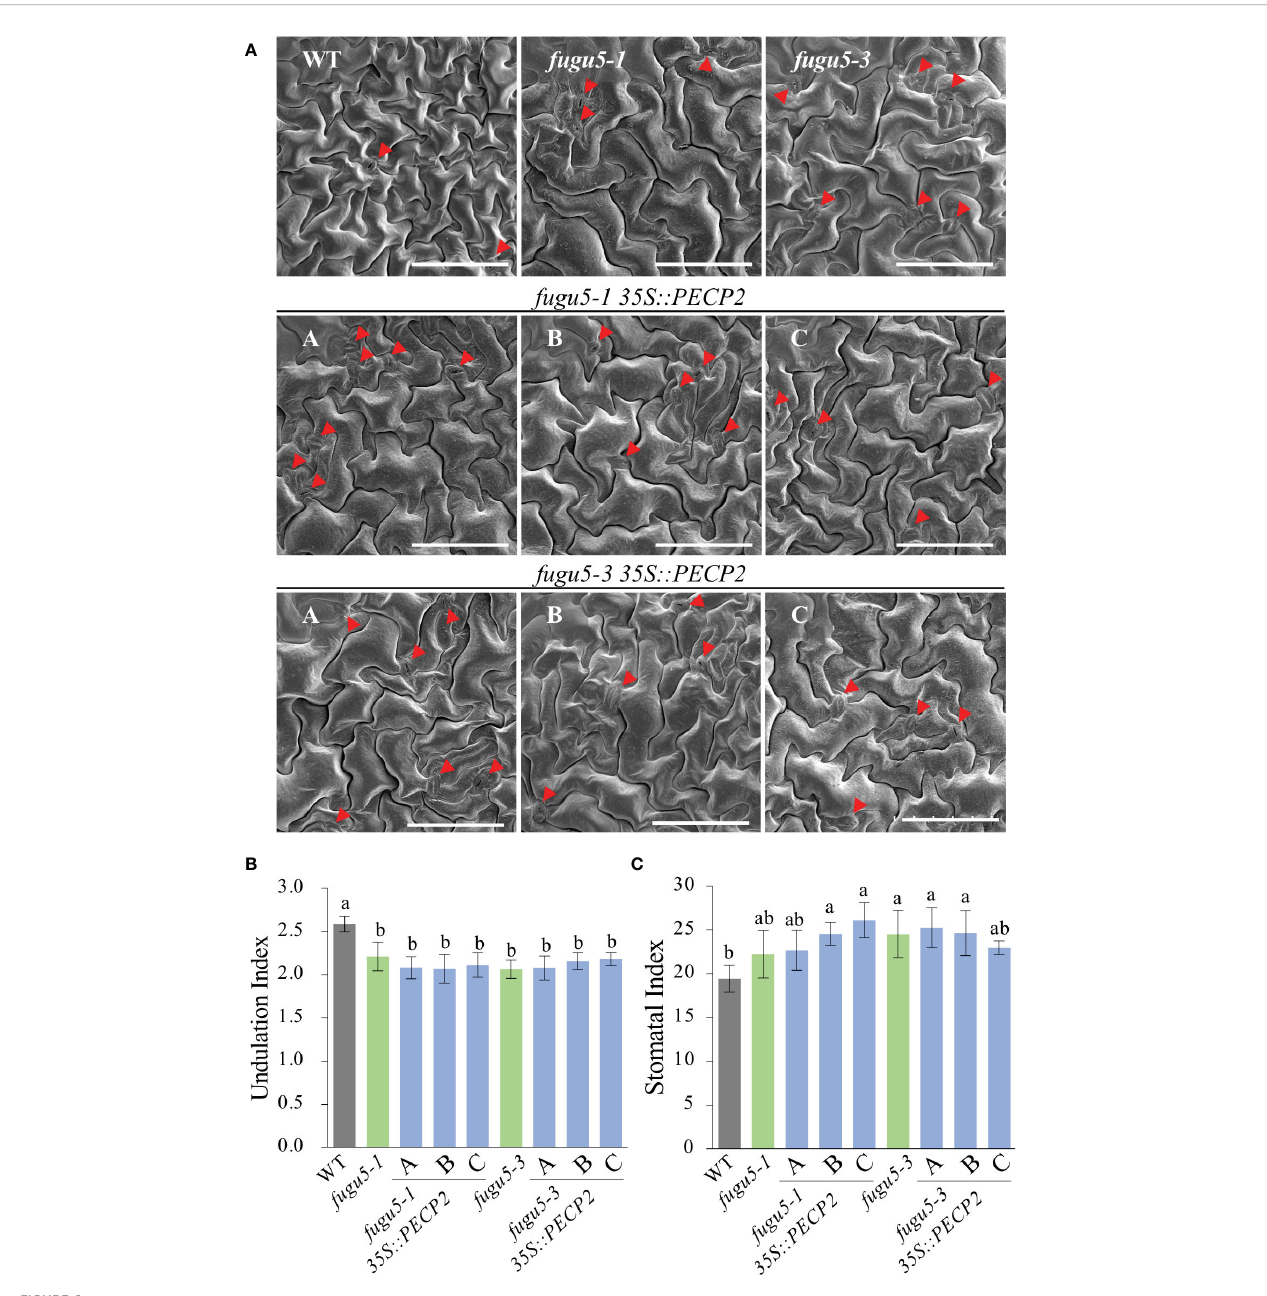
FIGURE 6 Quanti fi cation of pavement cell complexity and stomata distribution on the cotyledon adaxial side in PECP2 overexpressing lines in the fugu5 background. (A) Representative SEM images of pavement cells (PCs) from the cotyledon adaxial side of the WT, fugu5-1 , fugu5-3 , fugu5-1 35S::PECP2 , and fugu5-3 35S::PECP2 lines at 25 DAS. Red arrowheads indicate stomata. Scale bar = 150 µm. (B) Undulation index (UI) of PCs. Data are means ± SD ( n = 5 cotyledons). (C) Stomatal index (SI) determined as the number of stomata per 100 PCs. Data are means ± SD ( n = 5 cotyledons). Each character represents a signi fi cant difference at P< 0.05 (Tukey ’ s HSD test). DAS, days after seed